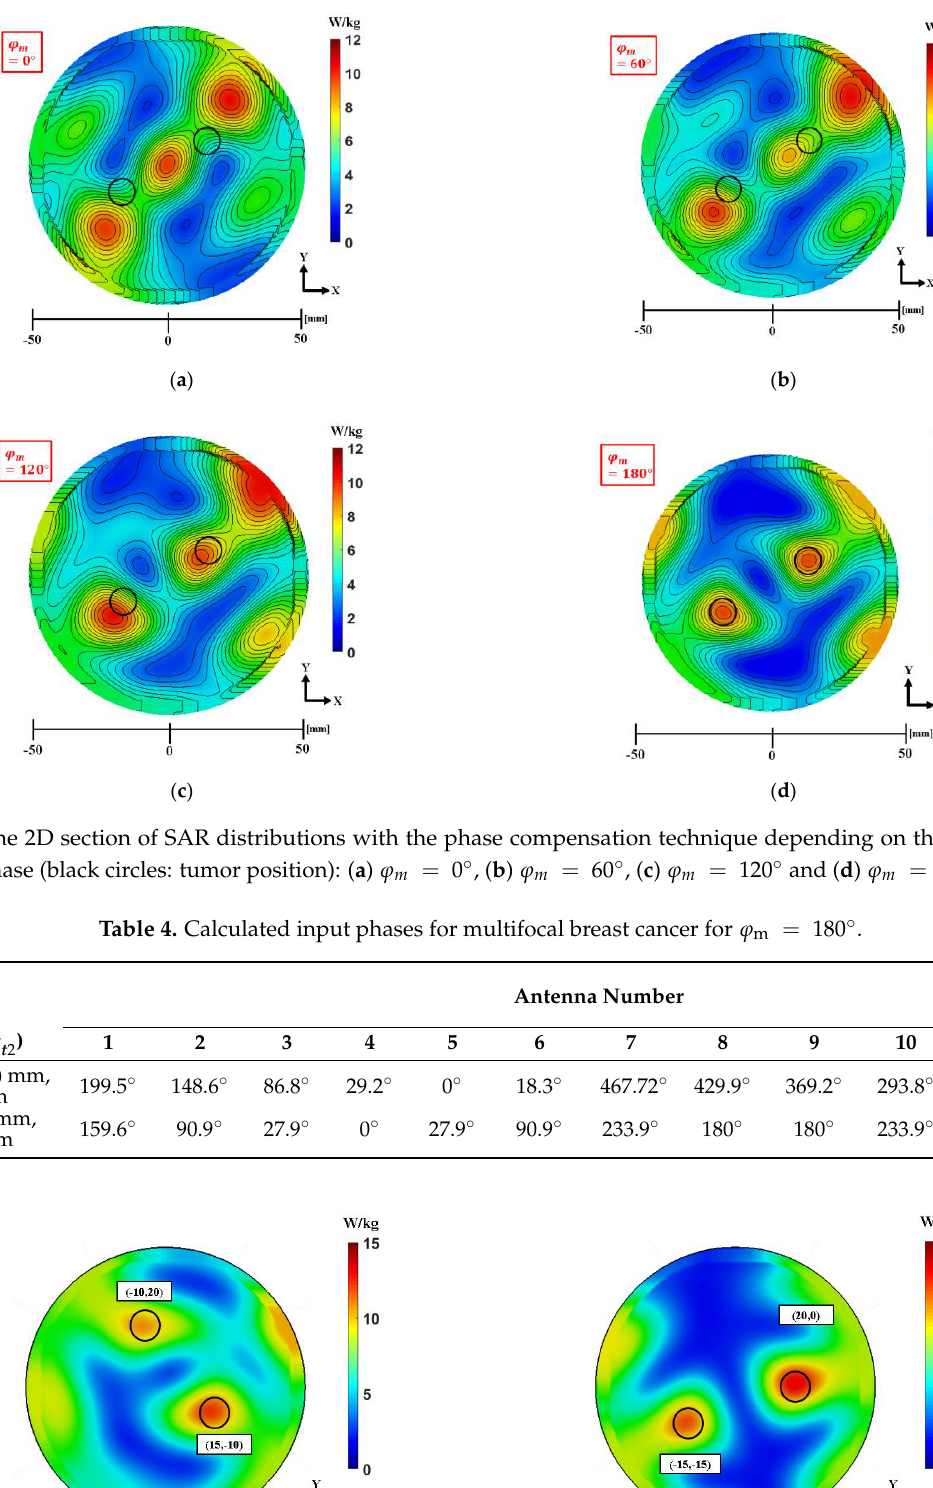
Figure 10. The 2D section of SAR distributions with the phase compensation technique (modified phase, 𝜑 m = 180° ): ( a ) two breast tumors located at (−10,20) mm and (15,−10) mm, ( b ) two breast tumors located at (20,0) mm and (−15,−15) mm.